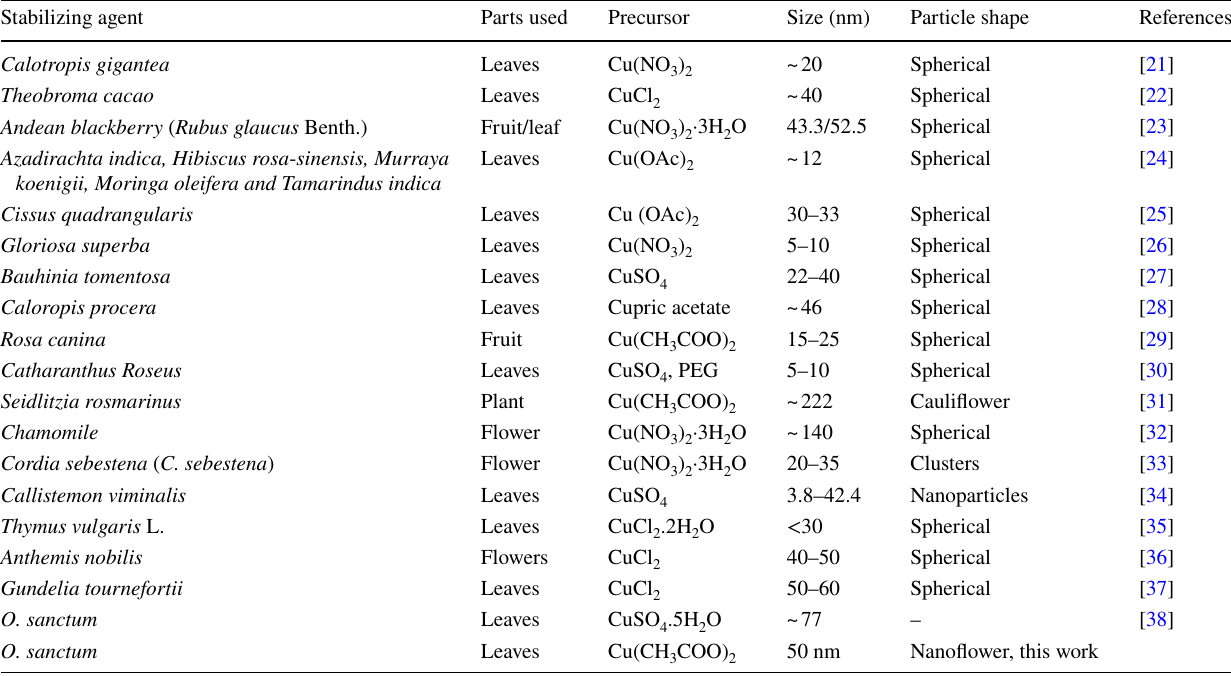
Table 1 Copper oxide nanoparticles prepared in Plant Extracts by chemical reduction methods [21–38] Stabilizing agent Parts used Precursor Size (nm) Particle